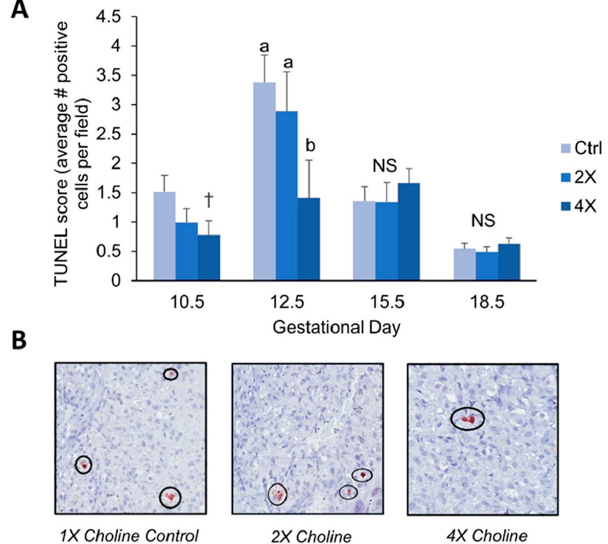
Figure 2. TUNEL score (calculated as the average number of TUNEL-positive cells per field) at E10.5, E12.5, E15.5, and E18.5 by maternal choline treatment ( A ). Representative images of TUNEL staining at E12.5 are shown in ( B ). Data were analyzed using mixed linear models with choline treatment as a fixed effect and maternal ID as a random effect. Litter size, fetal genotype, and fetal sex were controlled for in the models as fixed effects. Values are presented as mean ± SEM. Different letters denote significant differences between means of the treatments at p ≤ 0.05. † denotes p < 0.1 versus 1X choline controls. n = 7–15 placentas per treatment per time point. NS,